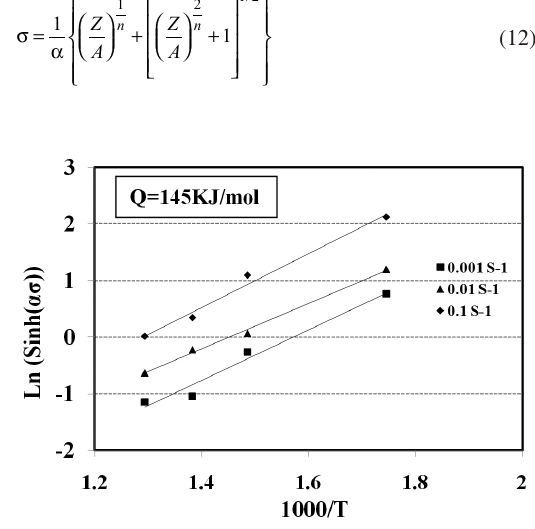
Figure 3. Relationship between ln [sinh ( ασ )] and ln ( ε  ) of rolled microstructure.